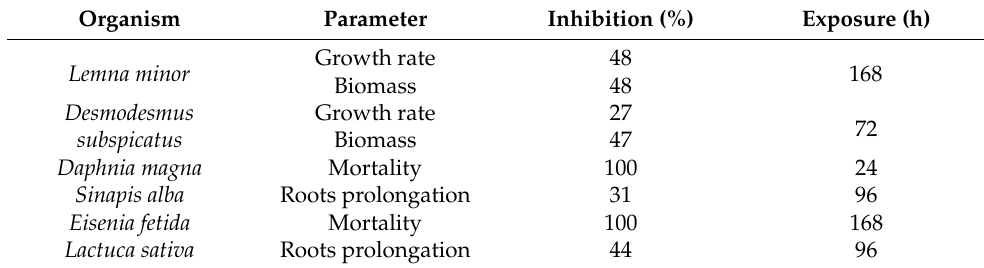
Table 5. Summarized results of ecotoxicity